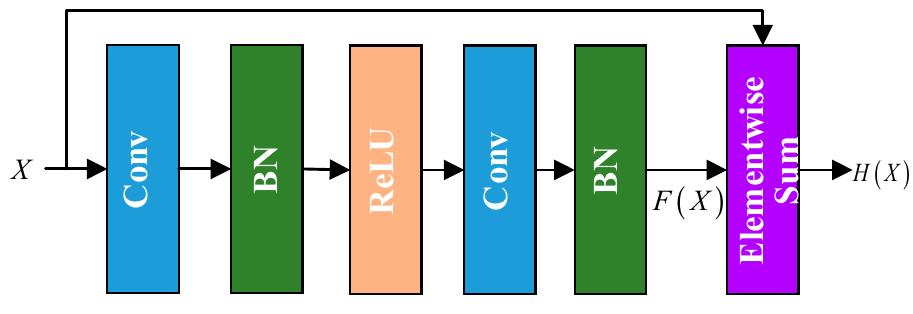
Figure 3. Schematic diagram of a residual block.